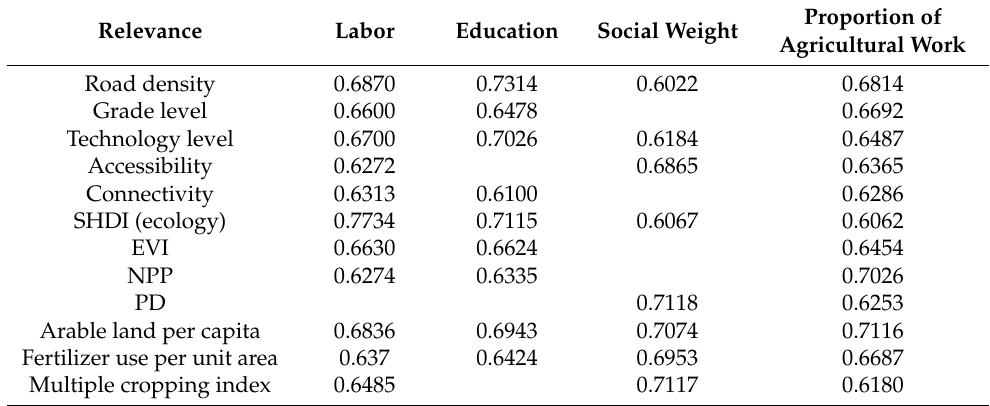
Proportion of Agricultural Work